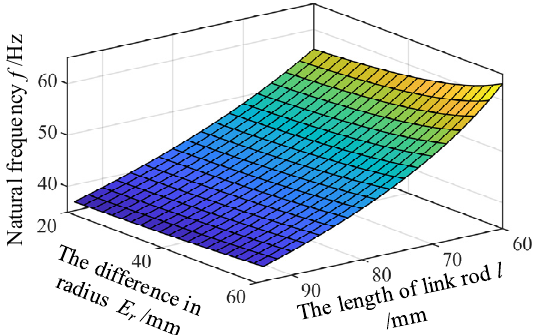
Figure 8. The influence of the variations of the length l of link rod and the difference in radius E r on the natural frequency.